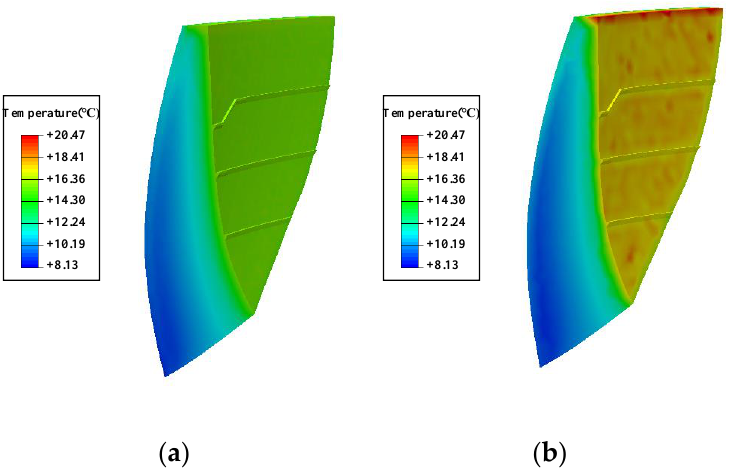
Figure 9. The temperature fields of the arch crown beam on a summer solstice day. ( a ) Consideration